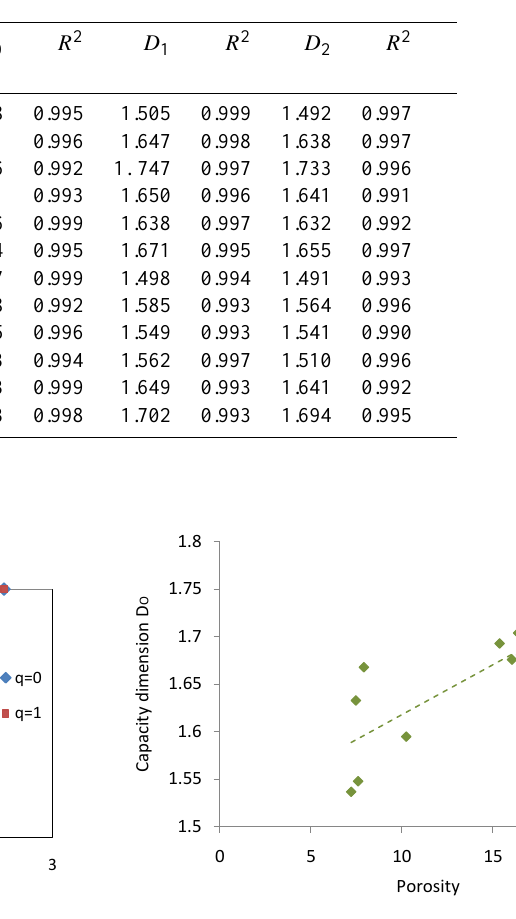
Table 1. Estimation of capacity dimension D 0 , information dimension D 1 and correlation dimension D 2 for samples S 1 to S 12 . R 2 is the coefficient of determination computed for the linear interpolation in the loglog plot.